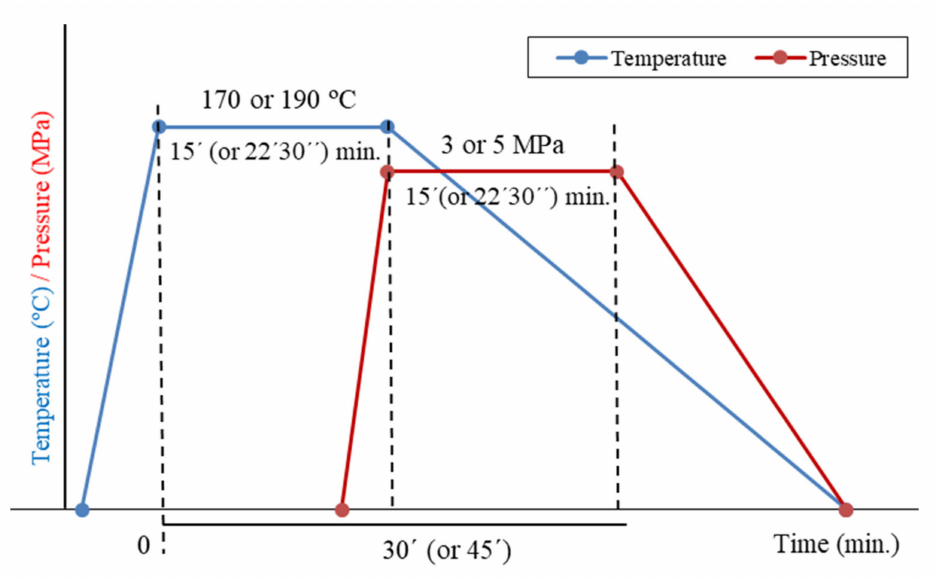
Figure 2. Basic manufacturing